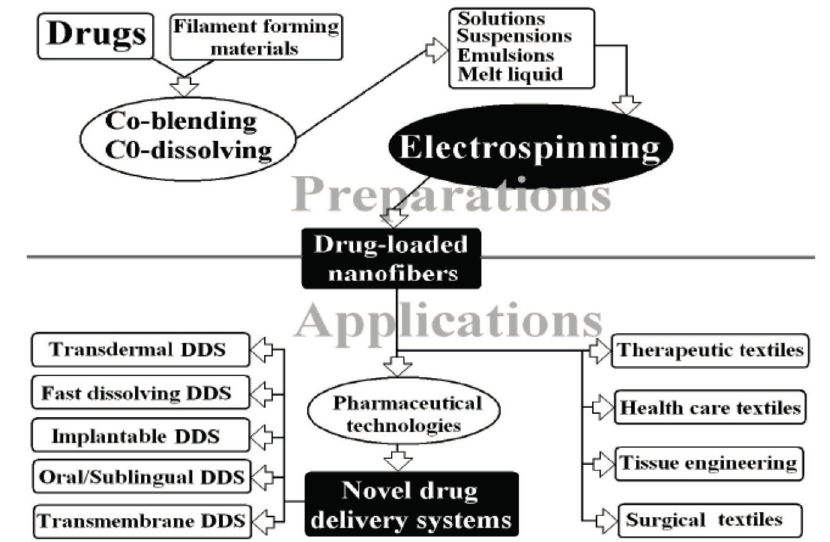
Figure 2. Application and preparation of electrospun drug loaded nanofibers. Reprinted with permission from [47], Copyright © 2009